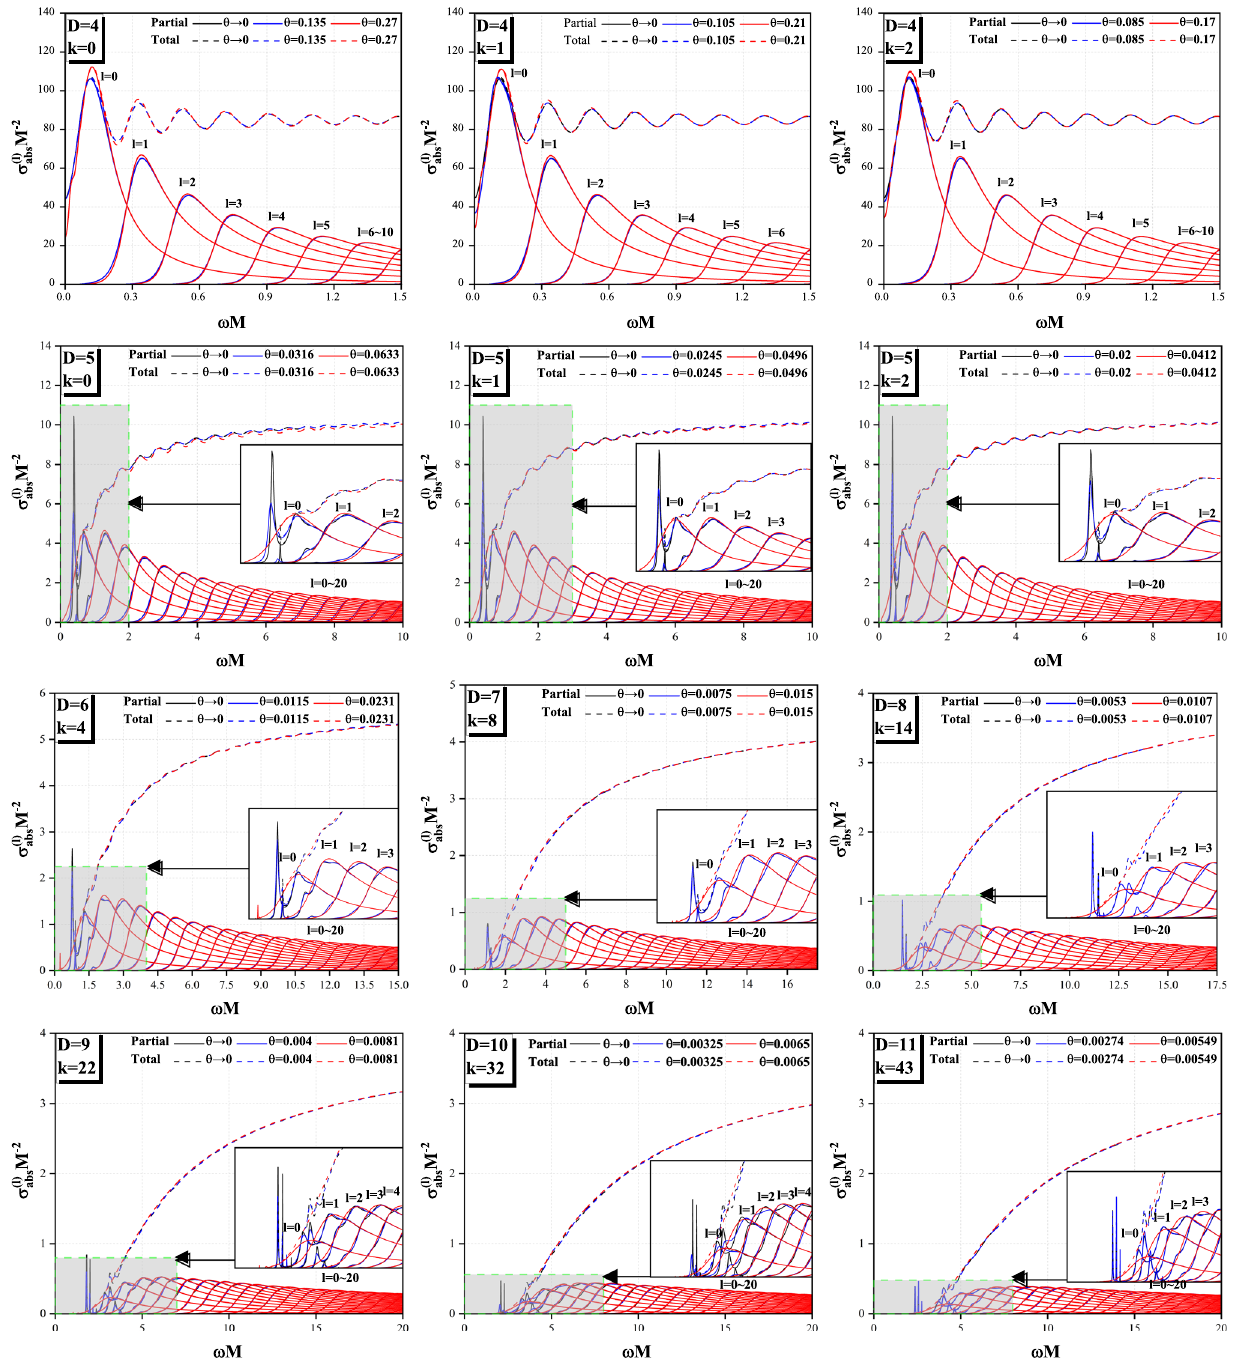
Fig. 3 The partial absorption cross section and total absorption cross section of high dimensional non-commutative black holes with different values of k and D are plotted respectively, and the mass is normalized to M=1. The parameter θ has a slight effect on the absorption cross